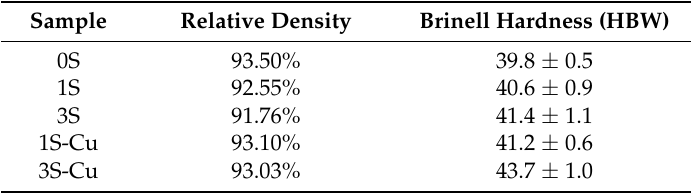
Table 3. Density and hardness of the composites.